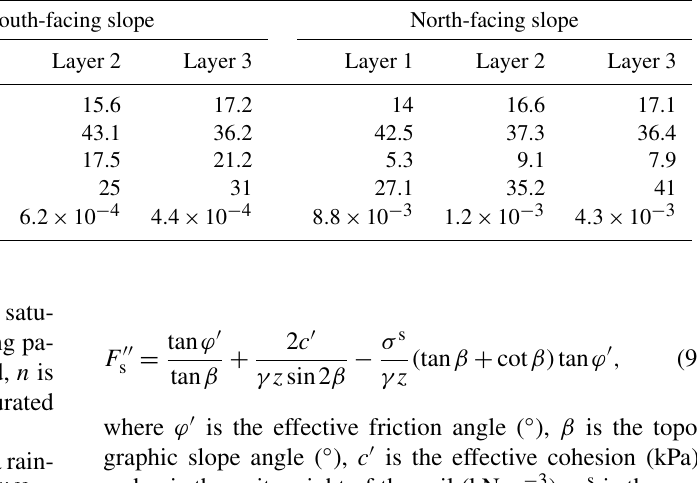
Table 1. Physical properties and strength parameters of the soil mass. Parameters South-facing slope North-facing slope Layer 1 Unit weight of soil (kNm − 3